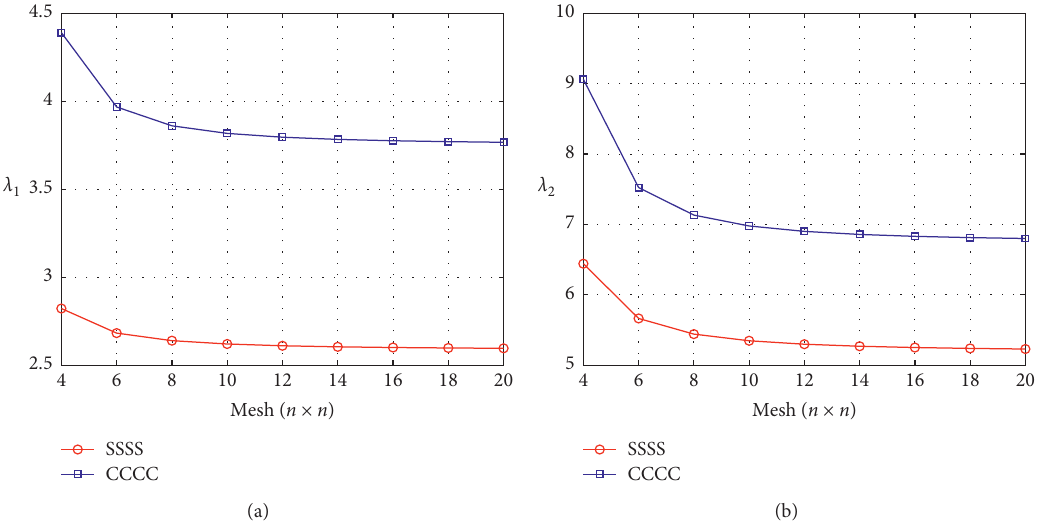
Figure 5: The convergence of the dimensionless frequencies of the plate: (a) dimensionless frequency λ